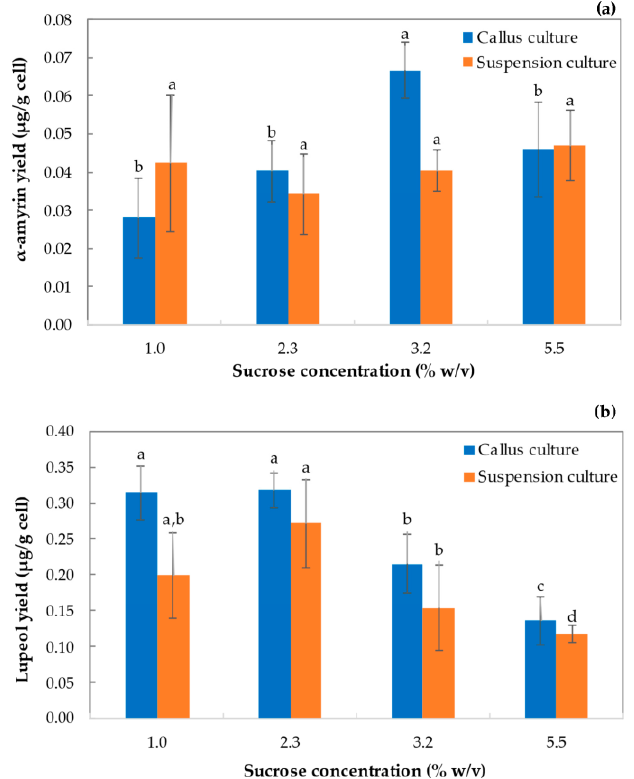
Figure 6. Effect of carbon source on triterpenes content. ( a ) α -Amyrin and ( b ) lupeol biomass yield in callus and suspension cultures of T. officinale. (Basal MS medium, sucrose 1.0%, 2.3%, 3.2%, and 5.5% ( w / v ), 3.0 mg/L NAA, 3.0 mg/L BAP, pH 5.8, 18 ± 2 °C, 0/24 h light/dark. 8th week of culture). Means with the same letter above the bars were not significantly different at the 0.05 level according to DMRT test. Bars indicate standard error.